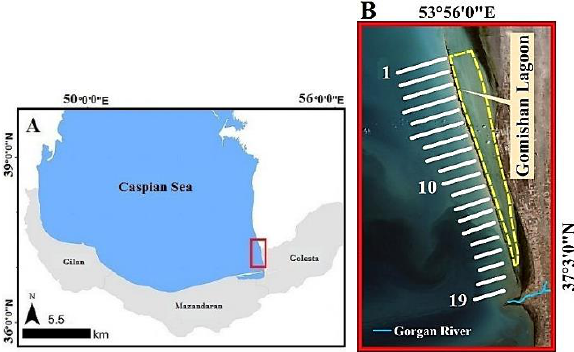
Figure 1. Figure 1. The location of the Caspian Sea (A); study area and depth transects shown in white line